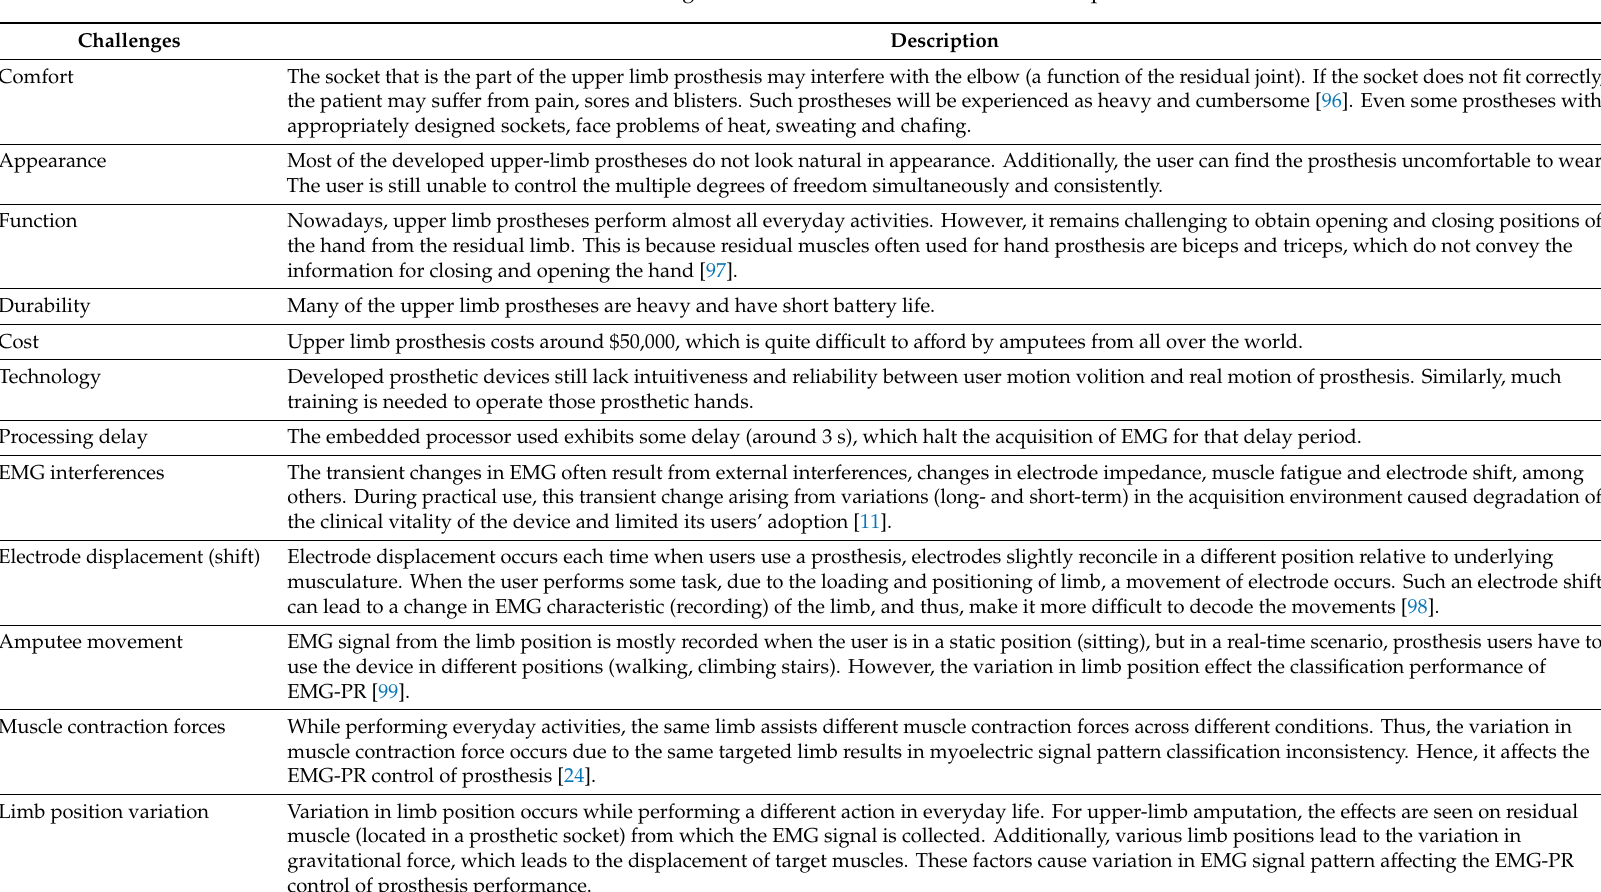
Table 4. Some of the challenges of real-time EMG-PR control of hand